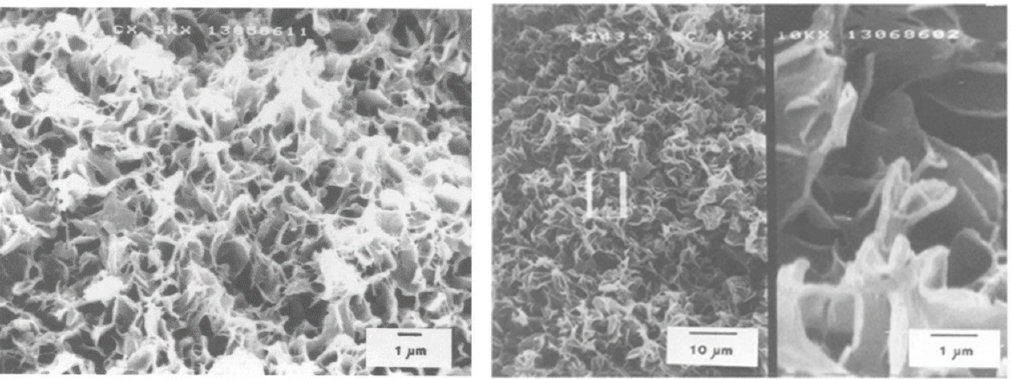
Figure 7. Scanning electron micrograph of the membrane structure resulting from the S–L phase separation of a 19 wt. % HDPE solution in mineral oil. The diluent was extracted with trichloroethylene (TCE) and quenched from 175 to 30 °C in water ( left ) or cooled from 175 to 30 °C at 10 °C/min ( right ), adapted from [5].